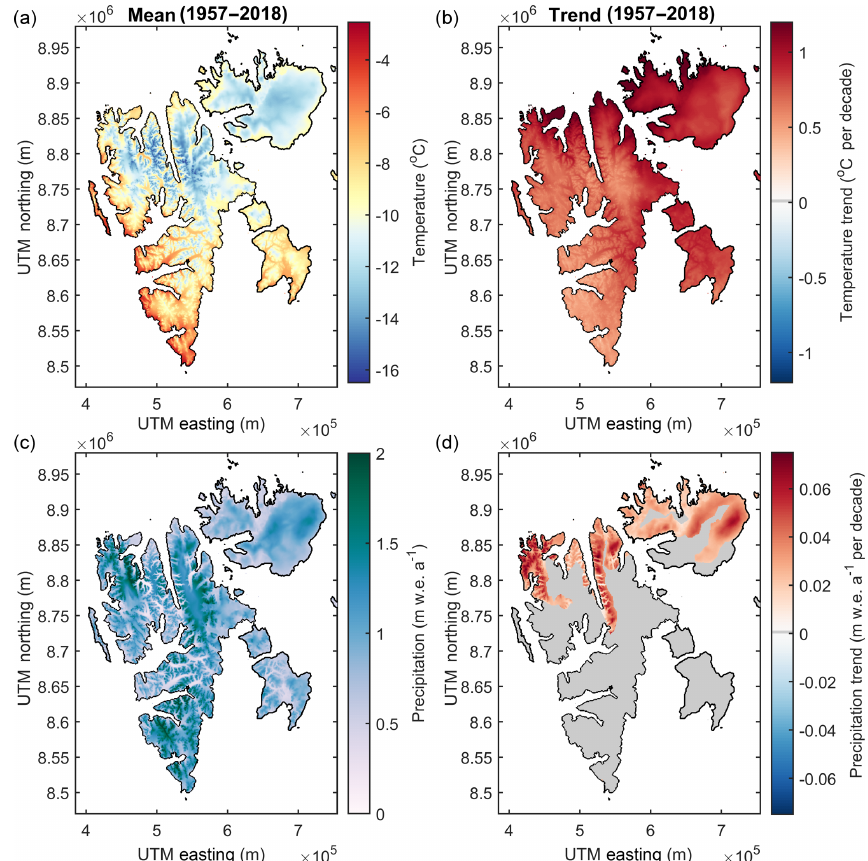
Figure 2. Long-term mean air temperature distribution (a) and trends (b) . Long-term mean precipitation distribution (c) and trends (d) . Non-significant trends at a 95% confidence interval are set to zero